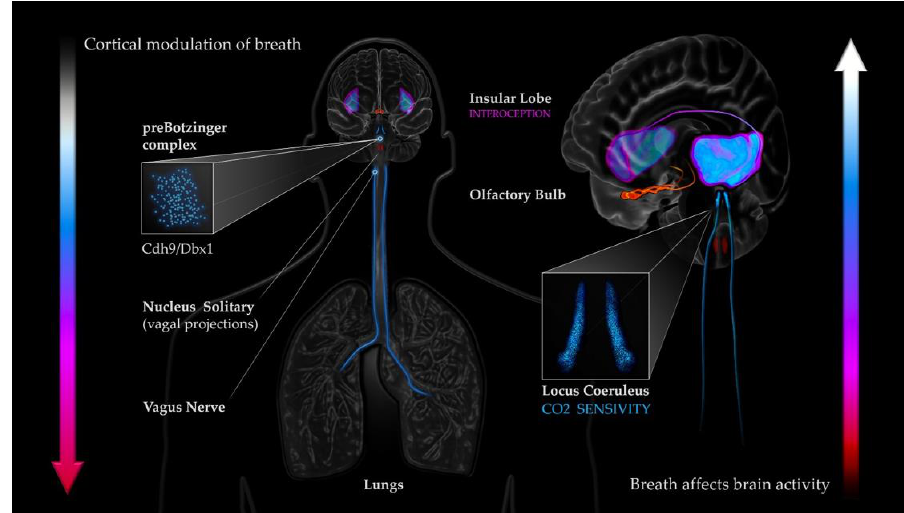
Figure 2. Potential coupling mechanisms between the breath and cortical activity. Synchronization between LC activity and the breath has been previously observed, with both voxel-based fMRI and pupil dilation (PD; [9]), and because activity in the LC is synchronized with the respiratory cycle, and due to the bi-directional neurophysiological coupling of these systems, we believe the LCs could have a unique position as a bridge between the breath and frontal attentional areas. As blood CO 2 levels are known to oscil- late in phase with respiration [74–76], it is reasonable to infer that an induced, possibly subtle, oscillation of electro-cortical activity should be phase-locked to the cycle of respi- ration. We thus chose to examine NA release by the LC as a potential mediator between respiration and TBR. While NA release from the LC is difficult to capture directly, due to the LC’s small size and prohibitive location within the brainstem, pupil diameter (PD) has been repeatedly shown to be an easily accessible and highly accurate proxy measure for LC/NA activity in several studies [2,77–81], even down to the scale of single LC neuronal spikes [77]. We examined these potential respiratory-locked fluctuations by measuring respiration, TBR, and PD during quiet eyes-open rest. We assessed synchronization via phase locking value [82], and directional information flow between signal sources via multi-variate Granger causality (MVGC; [83]). Based on our previous findings of respira- tory-modulated PD and LC activity, we expected to again observe synchronization of PD, as well as a corresponding oscillation of TBR, in line with the effect of LC/NA activity on attentional state, both synchronized to the respiratory cycle. We also hypothesized a Granger-causal informational exchange bi-directionally between all signal sources, given the established neurophysiological inter-dependence of these systems. 2. Methods 2.1. Participants All experimental procedures were approved by the Trinity Research Ethics Commit- tee (SPREC082014-1) and were performed in accordance with the Declaration of Helsinki. Thirteen participants (m ( 5), f (8); age: 22–56) who took part were informed of the testing procedures, made aware that their participation was voluntary, and that their data would be stored anonymously for up to 5 years following the study. Participants gave informed consent to participating by signing a consent form indicating their willingness to partici-